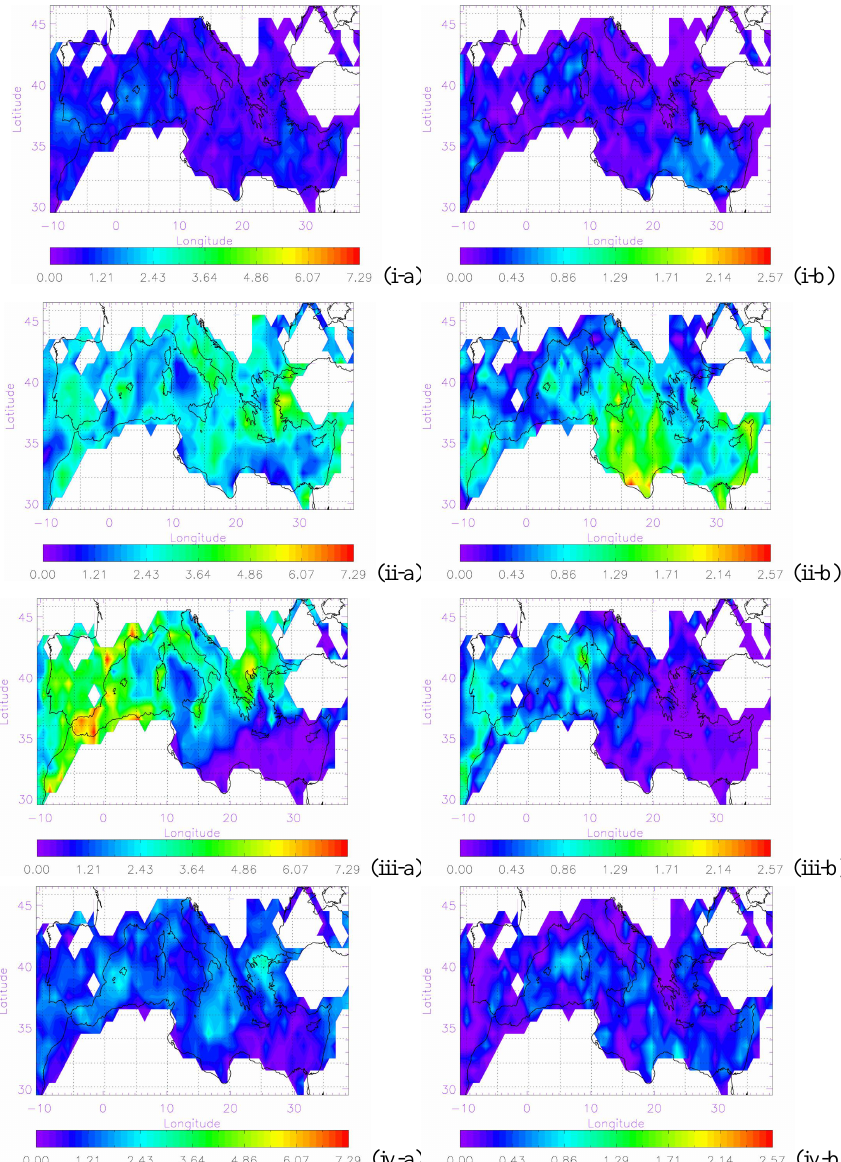
Fig. 3. As in Fig. 2 but for: (i) winter, (ii) spring, (iii) summer and (iv) autumn. Columns (a) and (b) show the results for strong and extreme Figure 3 (continued). As in Figure 2 but for: (i) winter, (ii) spring, (iii) summer and (iv) aerosol events, autumn. Columns (a) and (b) show the results for strong and extreme aerosol events, respectively.